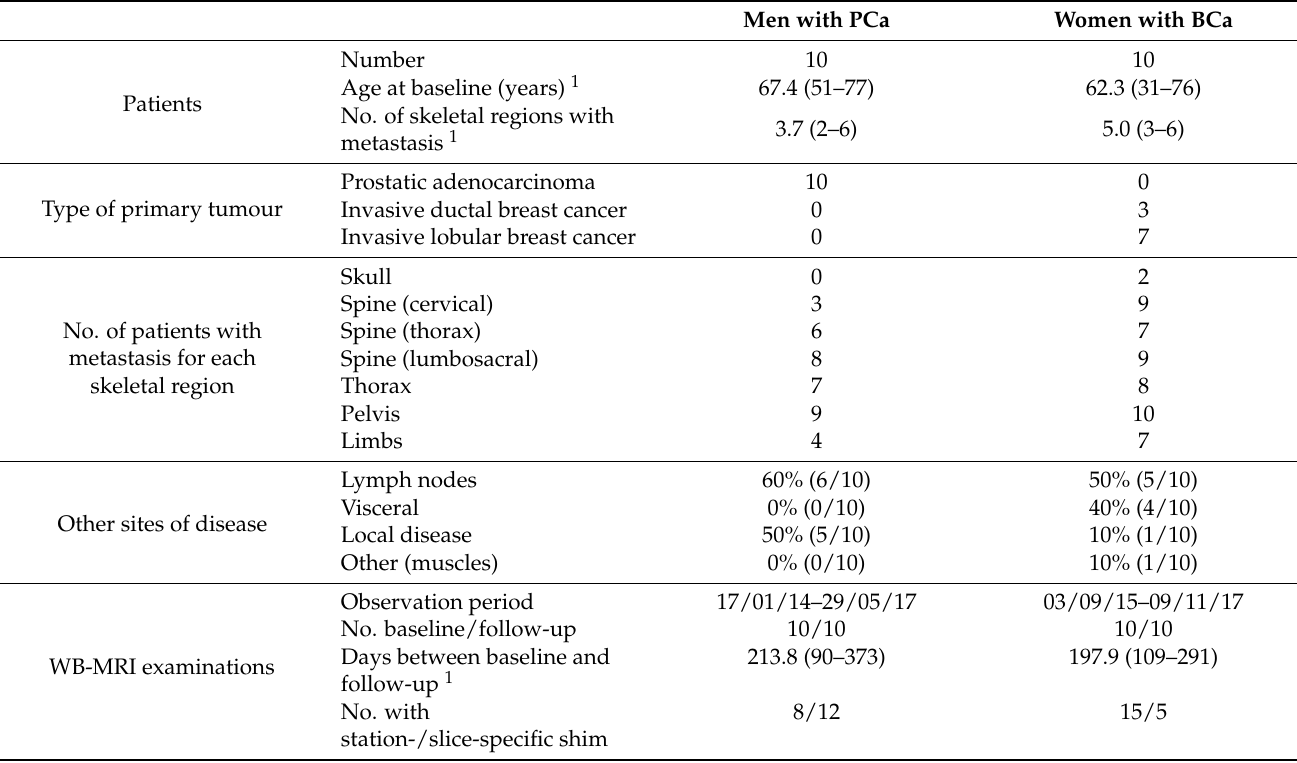
Table 2. A summary of clinical and demographical information. Men with PCa Women with